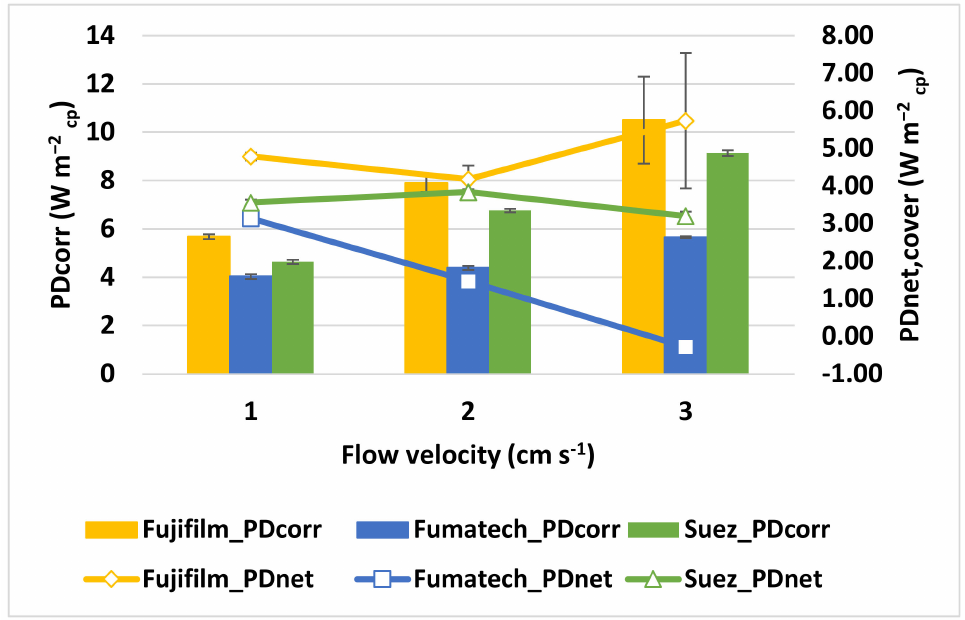
Figure 10. Influence of fluid velocity on power density for the different configurations under the